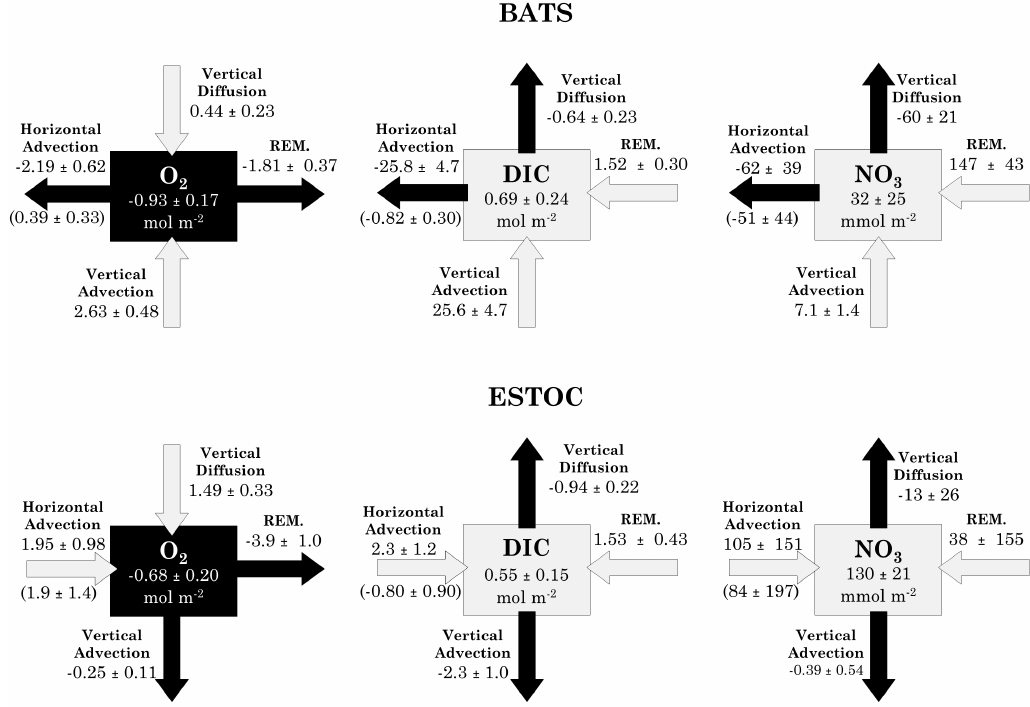
Fig. 9. Integrated model terms computed from 110m down to 250 m, and from April to December. REM is remineralization. Integrated geostrophic horizontal advection term is shown in brackets. White (black) arrows and boxed represent net gain (lost). Rates are expresed in mol m − 2 for oxygen and DIC and in mmolm − 2 for